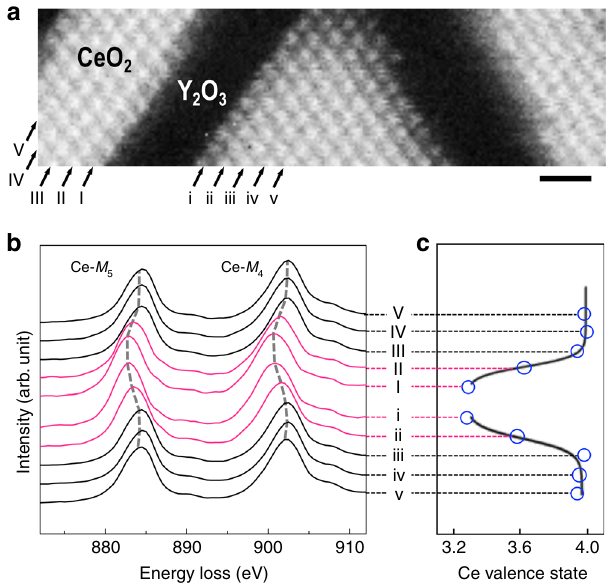
Fig. 3 Interfacial valence changes seen by STEM/EELS. a Atomic- resolution EELS map for the Ce- M 4,5 edges from a local area in a CeO 2 – Y 2 O 3 nanobristle, revealing an atomically abrupt (111) interface. The scale bar corresponds to 1 nm. b Ce- M 4,5 EELS spectra averaged along the (111)Ce atom planes. The dashed lines indicate the chemical shift of the Ce- M M 5 and Ce- 4 edges at the interface between CeO 2 and Y 2 O 3 as indicated by the EELS spectra in red. The latter were taken from the two interfacial CeO 2 layers interleaved by a Y 2 O 3 layer, indicating the presence of reduced CeO 2 layers (~2 u.c. thick). c Average Ce valence states in the (111)Ce atom planes indicated in b , revealing the valence change in interfacial CeO 2 layers.